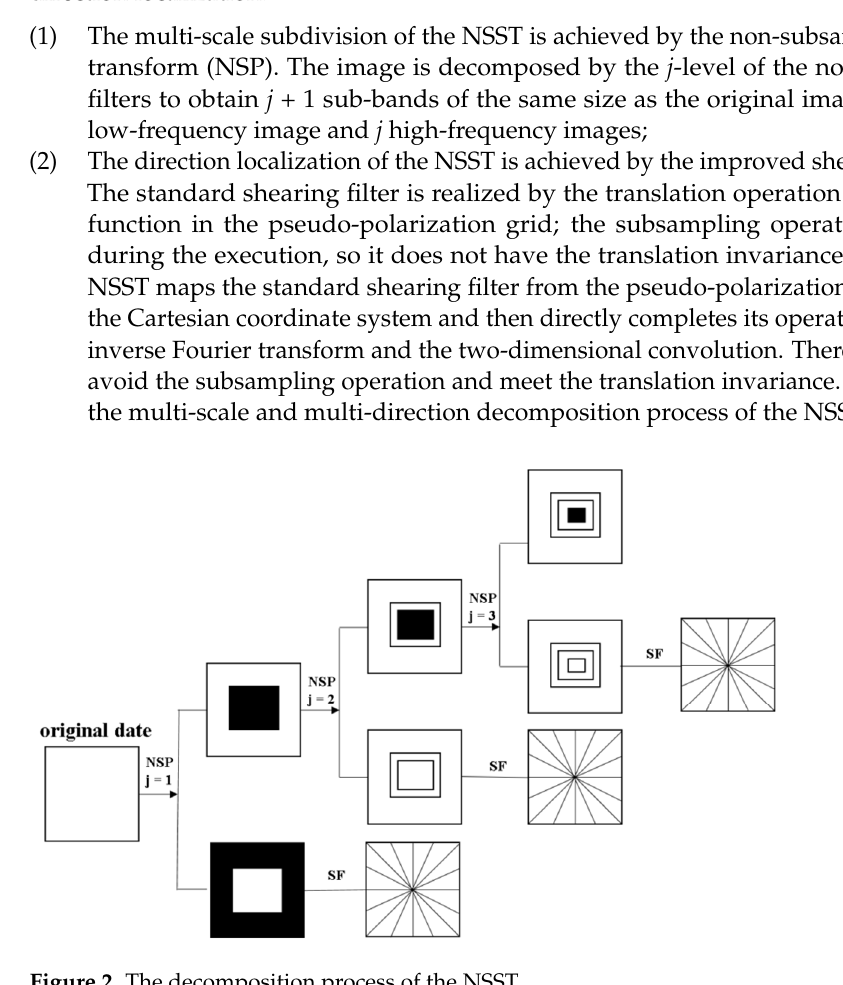
Figure 2. The decomposition process of the